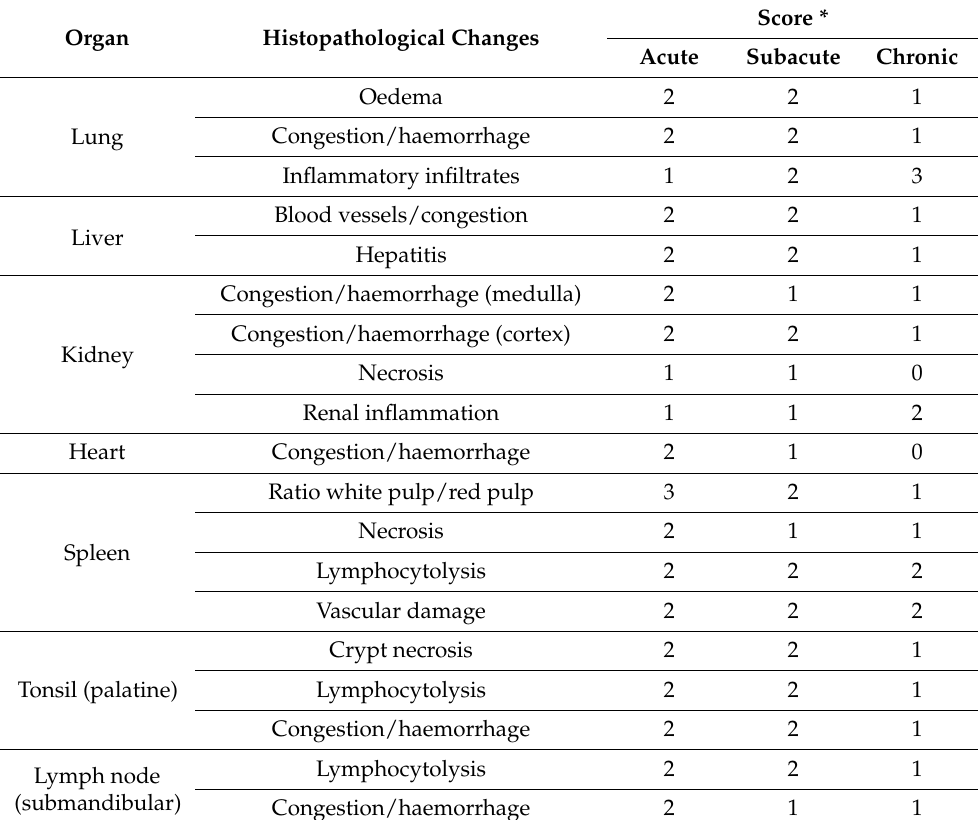
Figure 5. Mean C-reactive protein (CRP) concentrations ( µ g/mL) in two measurements before (the − 2, − 1 day) and six measurements after the detected viremia (1–6 days); *,** - statistically significant, respectively; p < 0.05, p < 0.01. Table 1. Histopathological evaluation of tissues from experimentally infected